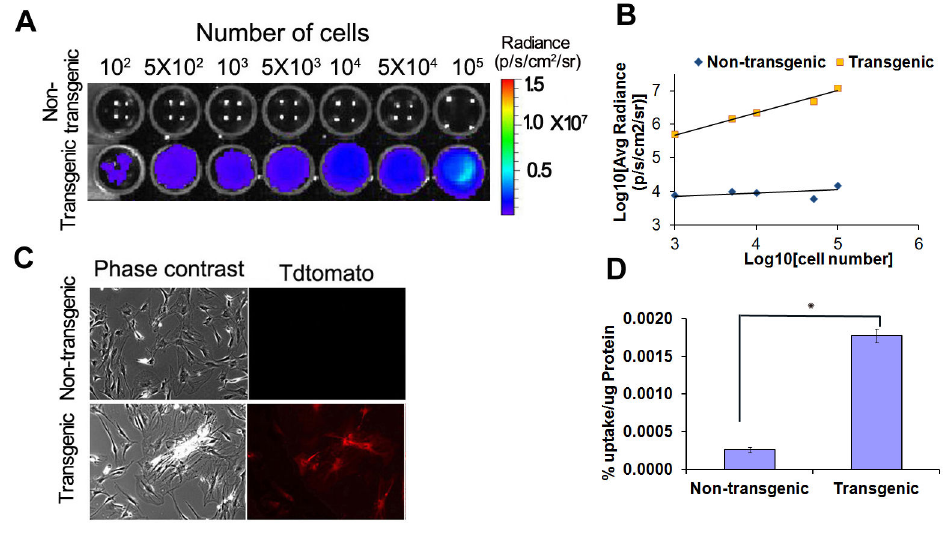
Figure 4. Reporter gene expression levels in MSCs isolated from tri-fusion transgenic mouse. (A) BLI of varying numbers of passage 4 MSCs (total cell count given above corresponding well, with color scale bar representing range of signal in photon per second per cm 2 per steradian). (B) Correlation of cell numbers (x-axis) with BLI signal demonstrated linear relationships, with R 2 values of 0.99. (C) Fluorescence imaging of passage 4 MSCs. (D) The tTK activity of passage 4 MSCs. Tri-fusion MSCs showed a significant higher cellular uptake compared with MSCs isolated from non-transgenic littermate (P<0.05). The tTK activity is expressed as (% percentage of uptake of [8-3H] penciclovir/µg protein (TRI = Tri-fusion). (*indicates p<0.05). doi: